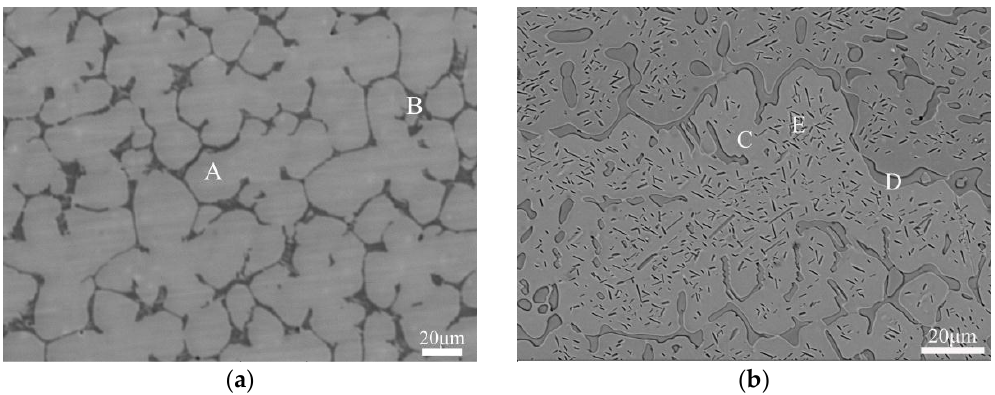
Figure 1. X-ray diffraction (XRD) patterns of as-cast and homogenized Al 0.5 CoCrFe HEAs (AC stands for as-cast; H stands for homogenized).